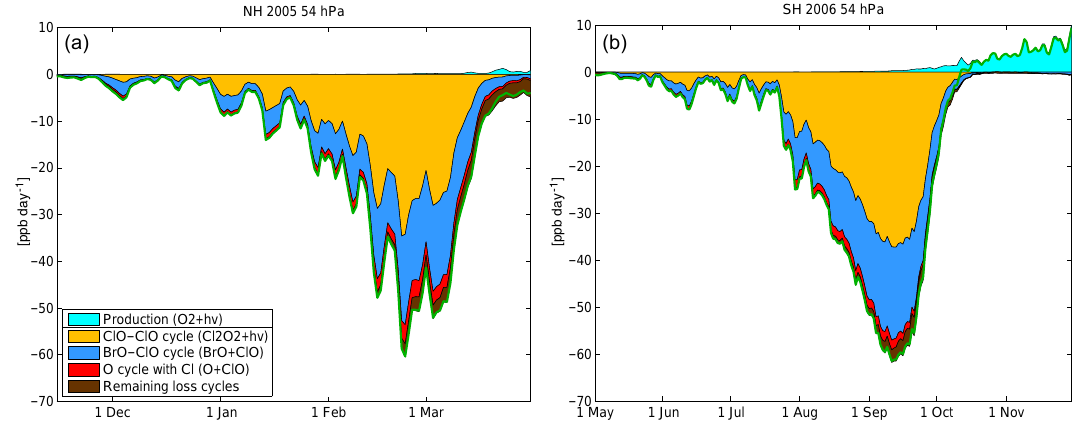
Figure 20. Vortex-averaged net chemical change of odd oxygen. The green line shows the net chemical change rate of ozone, which nearly equals the change rate of odd oxygen at this altitude. The contribution of different catalytic cycles to the ozone loss is shown by the reaction rates of their rate-limiting step. Only the three most important cycles are shown; the contribution of other cycles is small. Ozone production, which is almost exclusively by the O 2 + hν reaction, is shown in